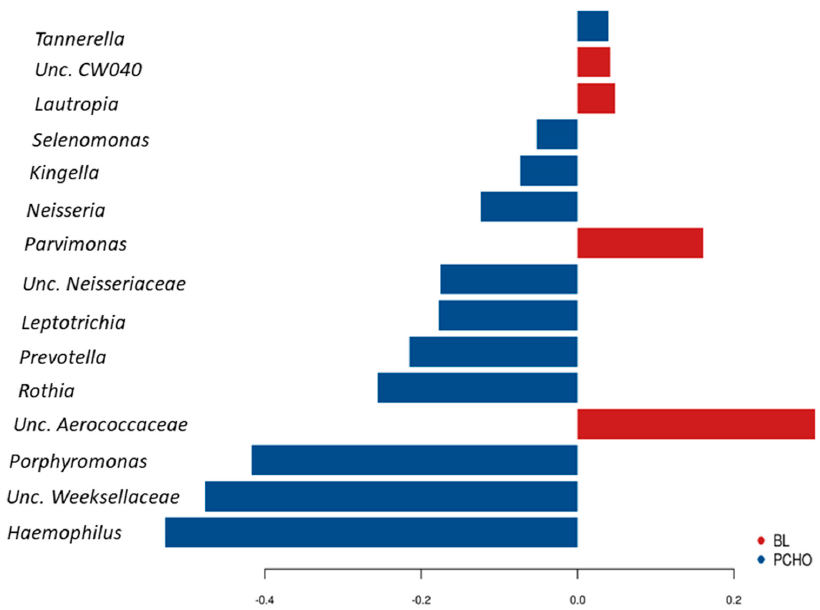
Figure 3. Genera differentiating between the oral microbiota profiles of athletes at baseline (BL, red) and after their consumption of the Periodised Carbohydrate diet (PCHO, blue) identified by sparse Partial Least Squares Discriminant Analysis (sPLS–DA).